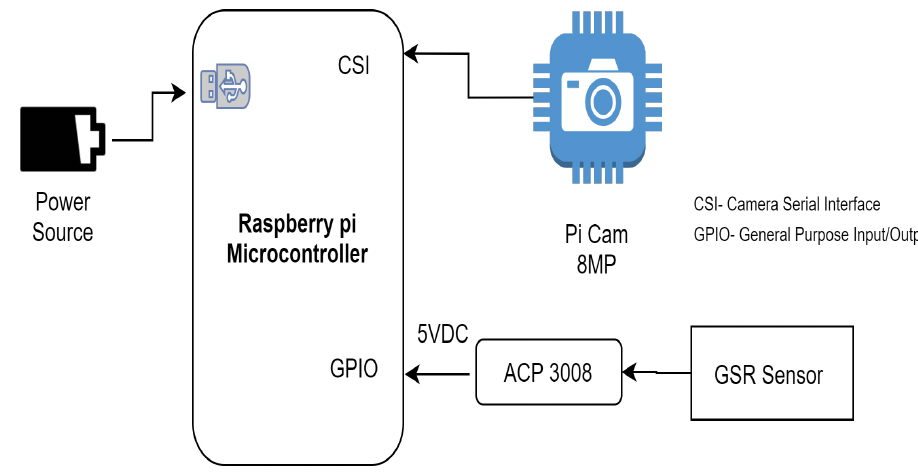
Figure 7. Schematic diagram of the hardware implementation of the proposed model.